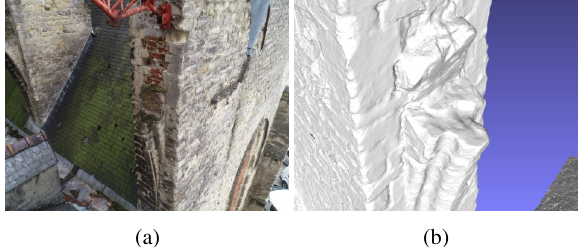
Figure 3: The highly detailed 3D model of the scene was obtained by employing a UAV (a) example of a full 20MP image, showing the detail of the captured texture (b) part of the highly detailed resulting mesh model